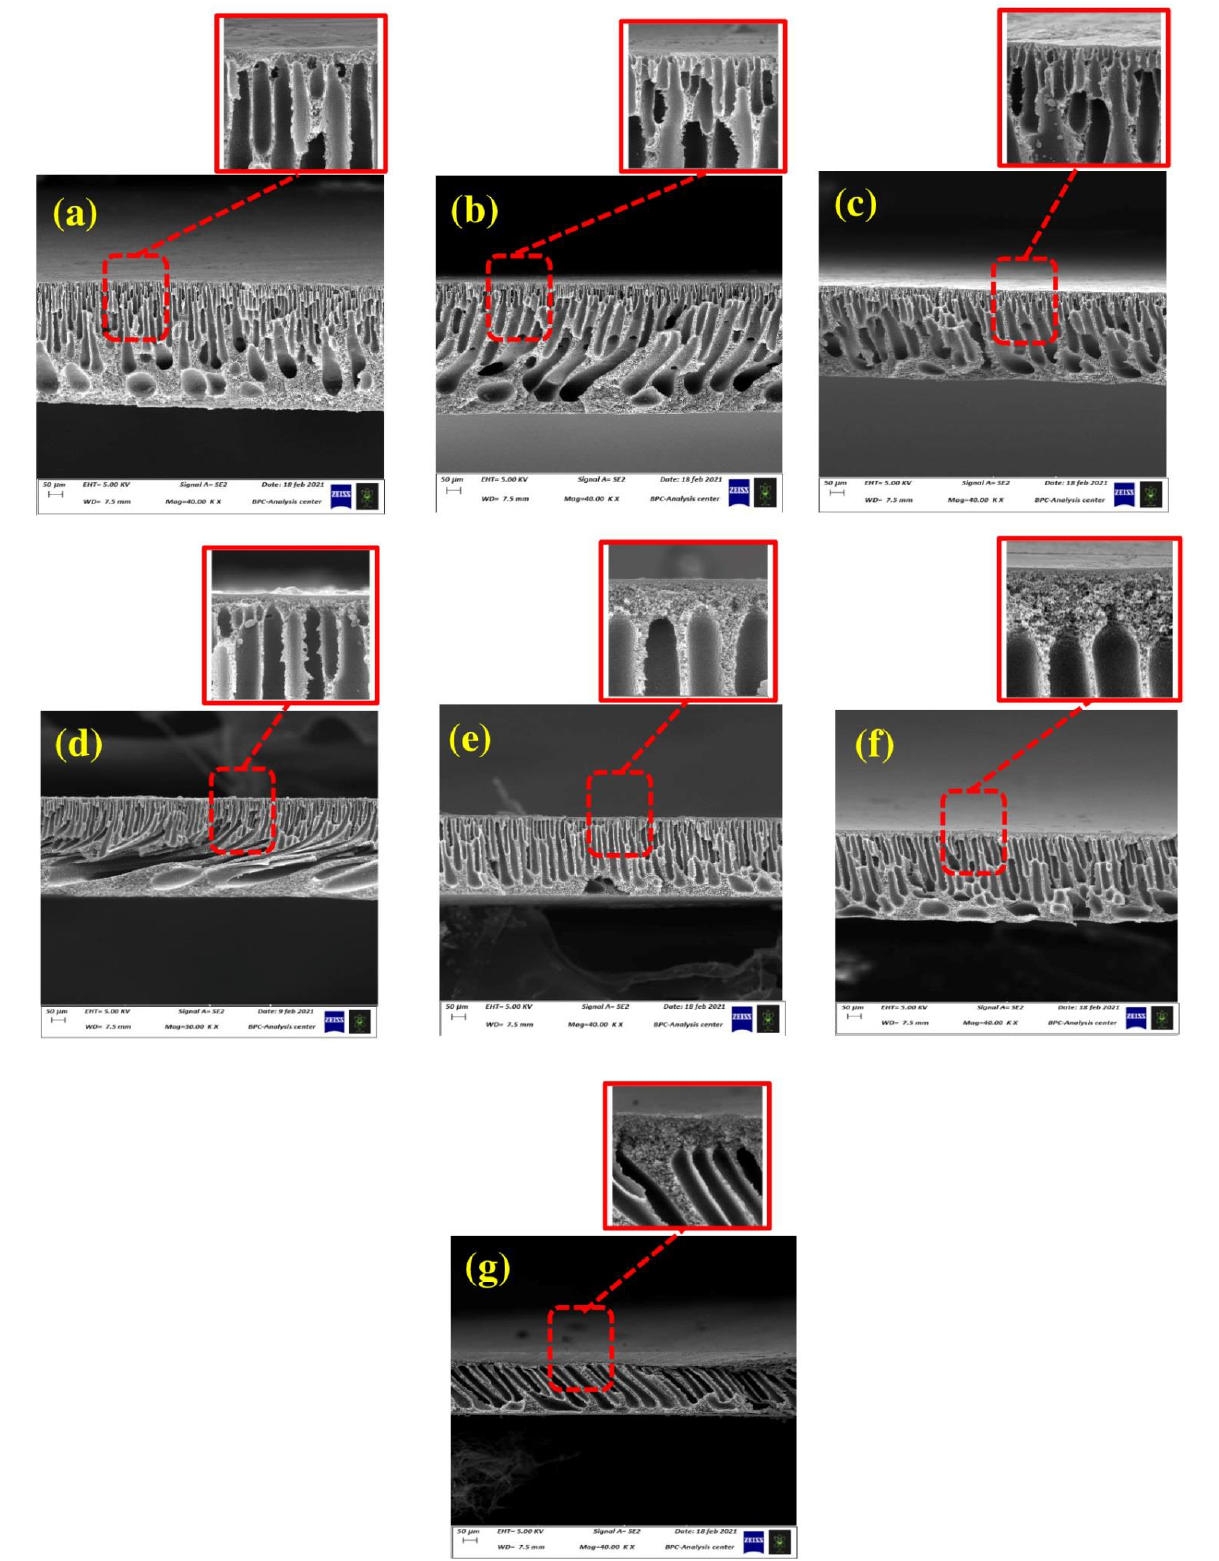
Figure 3. FE-SEM cross-sectional images of ( a ) PES, ( b ) PES/PTGM (1 wt.%), ( c ) PES/PTGM (3 wt.%), ( d ) PES/PTGM (5 wt.%), ( e ) PES/PTGM (7 wt.%), ( f ) PES/PTGM (9 wt.%), and ( g ) PES/PTGM (11 wt.%)